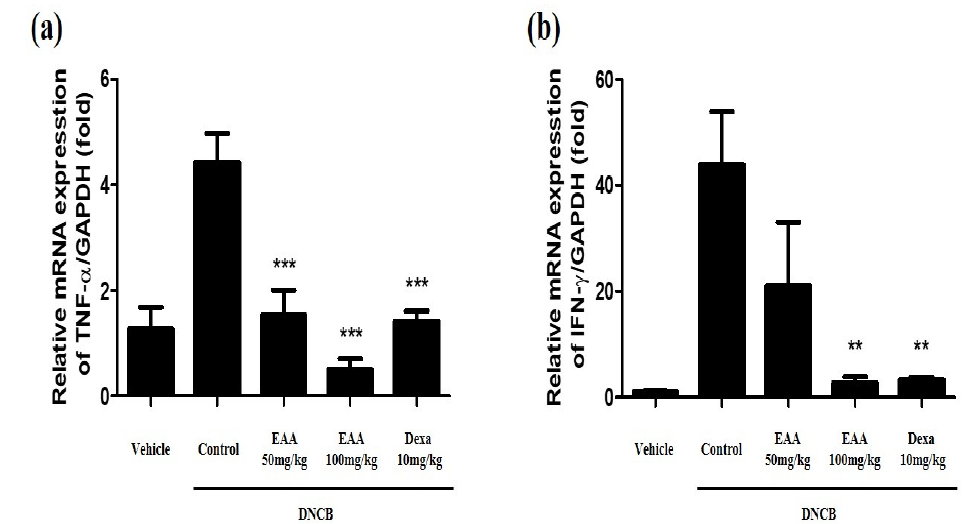
Figure 6. Inhibitory effects of EAA on the DNCB-induced pro-inflammatory cytokine production on skin tissue in the in vivo model. Production of ( a ) TNF- α and ( b ) IFN- γ was determined using real-time RT-PCR. Where applicable, data are presented as the mean ± S.E. (n = 4). Bars with different letters indicate statistically significant differences at ** p < 0.01 and *** p < 0.001 compared with the control group (solvent).